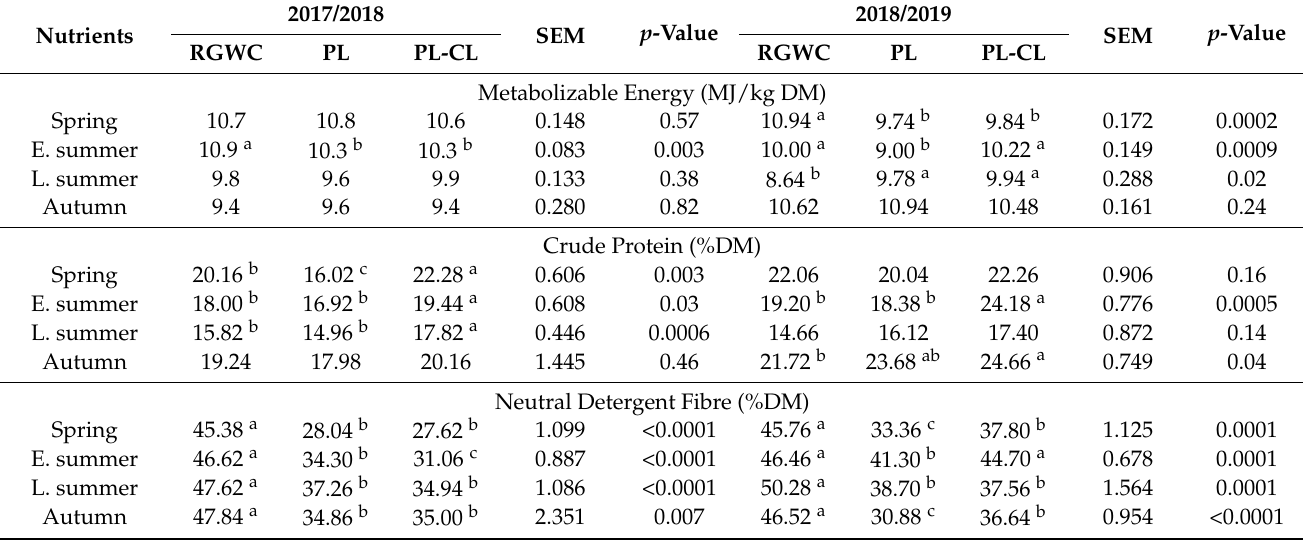
Table 1. Nutritive characteristic of plantain (PL), plantain–clover mix (PL-CL), and ryegrass–white clover (RGWC) pastures grazed by lactating dairy cows over two